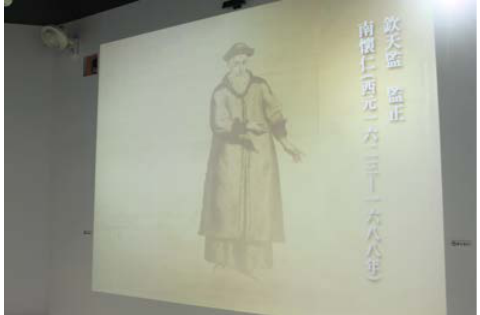
Figure 3. Depiction of Ferdinand Verbiest’s portrait is projected on the